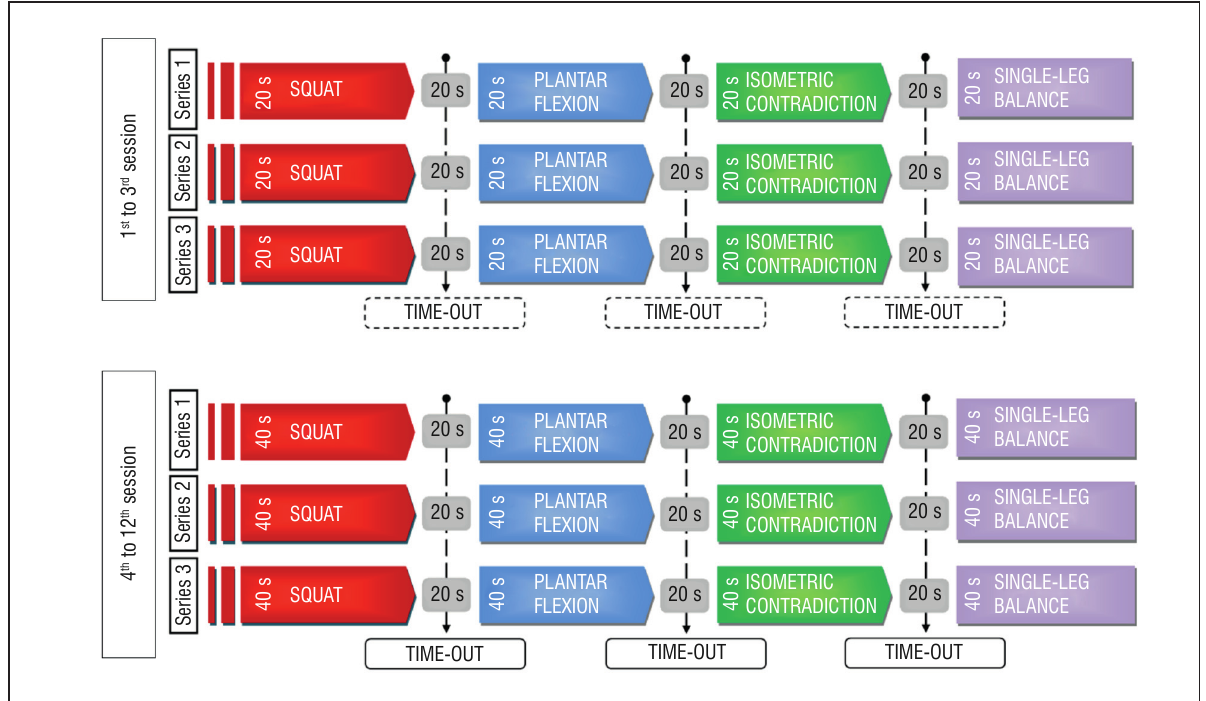
Figure 2 - Whole body vibration treatment protocol: A – Held the first three sessions; B – Held the last nine sessions Source: Research